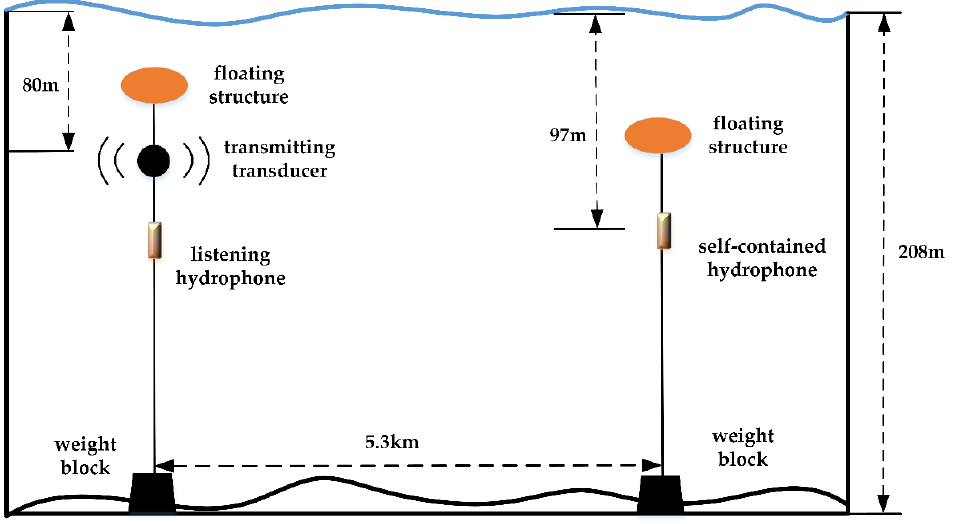
Figure 9. Sea trial program.